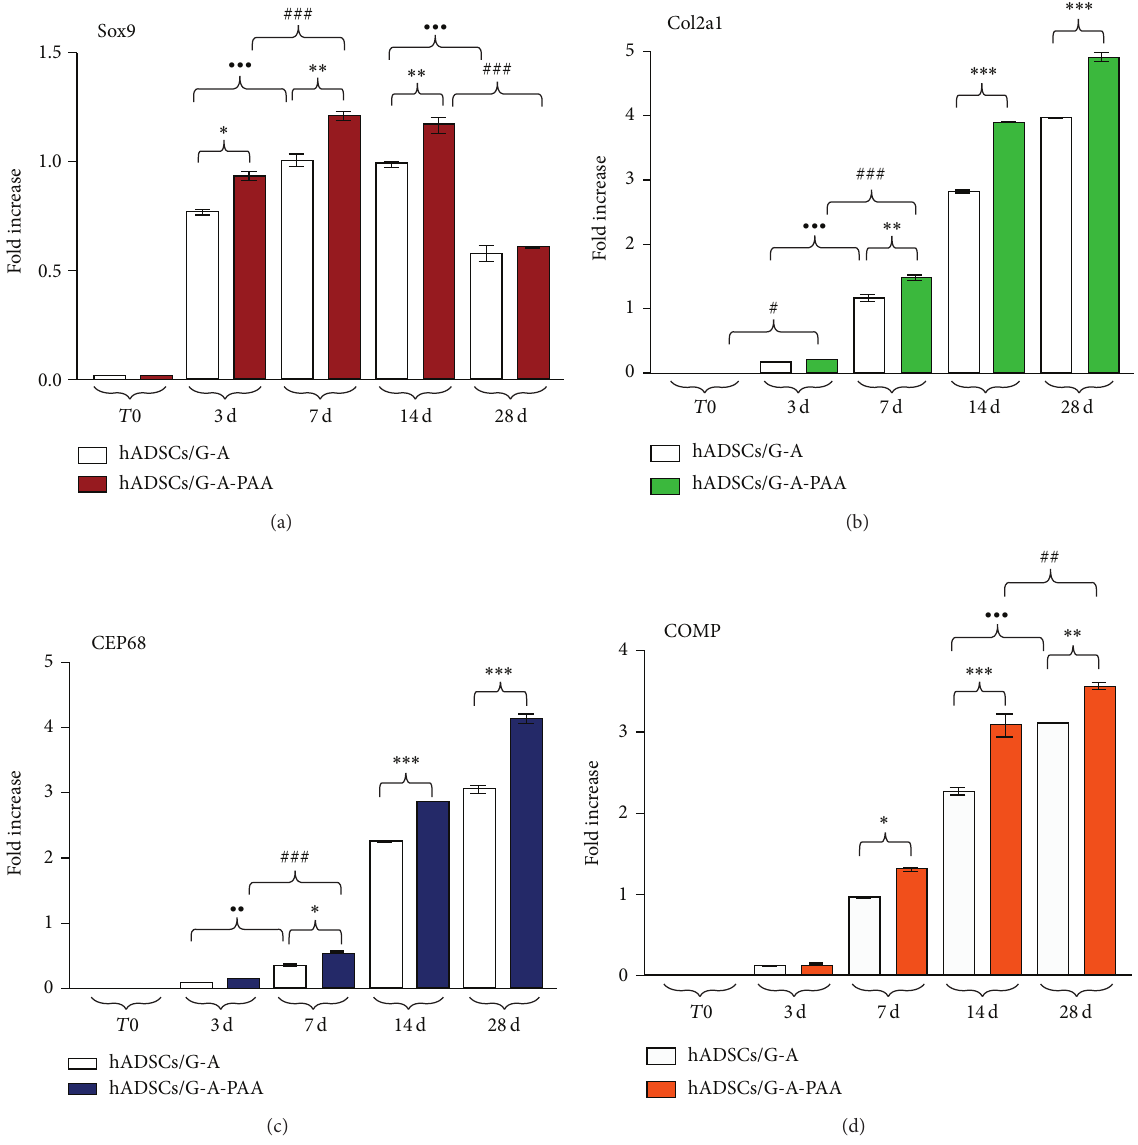
Figure 7: Gene expression profiles of (a) Sox9 ( ∗ 𝑃 < 0.05 (hADSCs/G-A-PAA versus hADSCs/G-A bioconstruct: 3 days); ∗∗ 𝑃 < 0.01 (hADSCs/G-A-PAA versus hADSCs/G-A bioconstruct: 7 days and 14 days); ∙∙∙ 𝑃 < 0.001 (hADSCs/G-A: 7 days versus 3 days and 28 days versus 14 days); ### 𝑃 < 0.001 (hADSCs/G-A-PAA: 7 days versus 3 days and 28 days versus 14 days)), (b) Col2a1 ( ∗∗ 𝑃 < 0.01 (hADSCs/G-A- PAA versus hADSCs/G-A bioconstruct: 7 days); ∗∗∗ 𝑃 < 0.001 (hADSCs/G-A-PAA versus hADSCs/G-A bioconstruct: 14 days and 28 days); ∙∙∙ 𝑃 < 0.001 (hADSCs/G-A: 7 days versus 3 days); # 𝑃 < 0.05 (hADSCs/G-A-PAA: 3 days versus T0); ### 𝑃 < 0.001 (hADSCs/G-A-PAA: 7 days versus 3 days)), (c) CEP68 ( ∗ 𝑃 < 0.05 (hADSCs/G-A-PAA versus hADSCs/G-A bioconstruct: 7 days); ∗∗∗ 𝑃 < 0.001 (hADSCs/G-A-PAA versus hADSCs/G-A bioconstruct: 14 days and 28 days); ∙∙ 𝑃 < 0.01 (hADSCs/G-A: 7 days versus 3 days); ### 𝑃 < 0.001 (hADSCs/G-A-PAA: 7 days versus 3 days)), (d) COMP ( ∗ 𝑃 < 0.05 (hADSCs/G-A-PAA versus hADSCs/G-A bioconstruct: 7 days); ∗∗ 𝑃 < 0.01 (hADSCs/G-A-PAA versus hADSCs/G-A bioconstruct: 28 days); ∗∗∗ 𝑃 < 0.001 (hADSCs/G-A-PAA versus hADSCs/G-A bioconstruct: 14 days); ∙∙∙ 𝑃 < 0.001 (hADSCs/G-A: 28 days versus 14 days); ## 𝑃 < 0.01 (hADSCs/G-A-PAA: 28 days versus 14 days)) as revealed by qPCR analysis and GraphPad Prism 3.0 data statistical